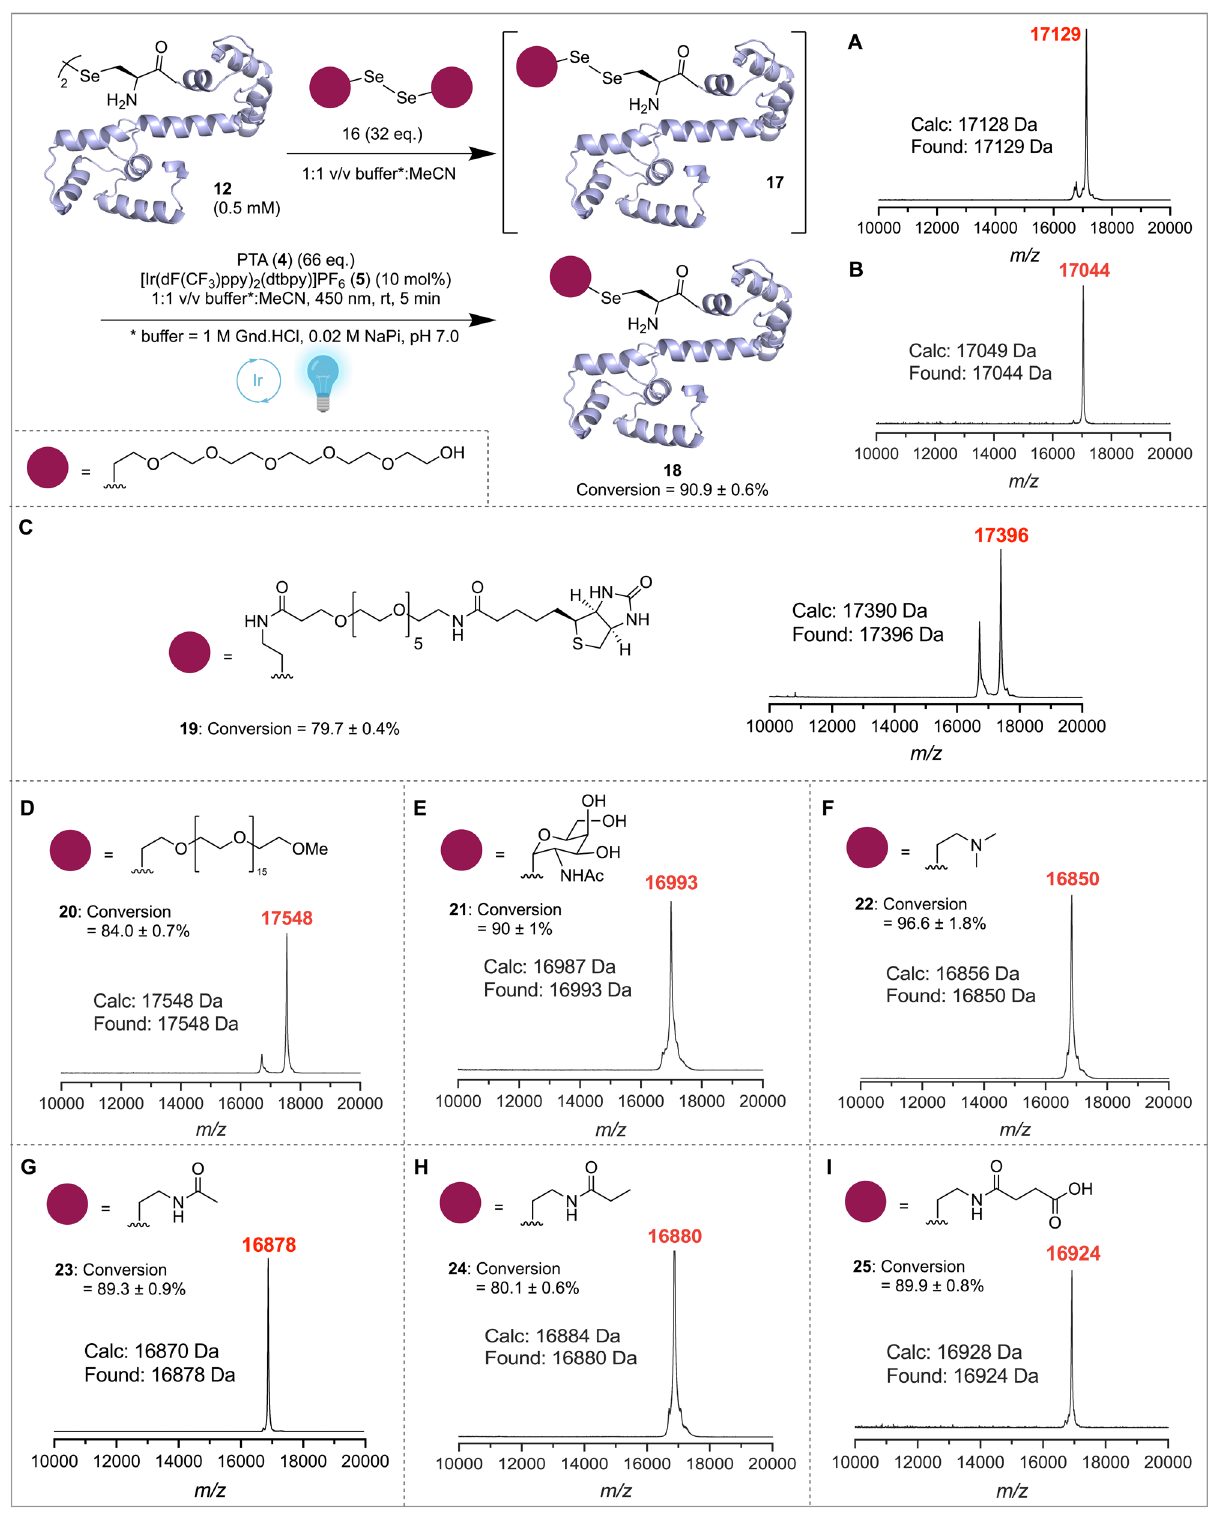
Fig. 3 | Late-stage modi fi cation of calmodulin (K148U) diselenide 12 via PDC. Functionalization of a CaM (K148U) diselenide 12 with [PEG 6 -Se] 2 ( 16 ) to afford PEG 6 -modi fi ed CaM (K148U) 18 ; mass spectra of the asymmetric diselenide 17 formed from mixing 12 and 16 ( A ) and subsequent photocatalytic contraction to afford 18 ( B ) are shown as insets. MALDI-TOF spectra of crude desalted reaction mixtures after PDC functionalisation with C biotin-PEG 5 - ( 19 ), D mPEG 17 - ( 20 ), E GalNAc- ( 21 ), F (Me) 2 NCH 2 CH 2 - ( 22 ), G AcHNCH 2 CH 2 - ( 23 ), H PropionylHNCH 2 CH 2 - ( 24 ), and I SuccHNCH 2 CH 2 - ( 25 ) are also inset. Reaction